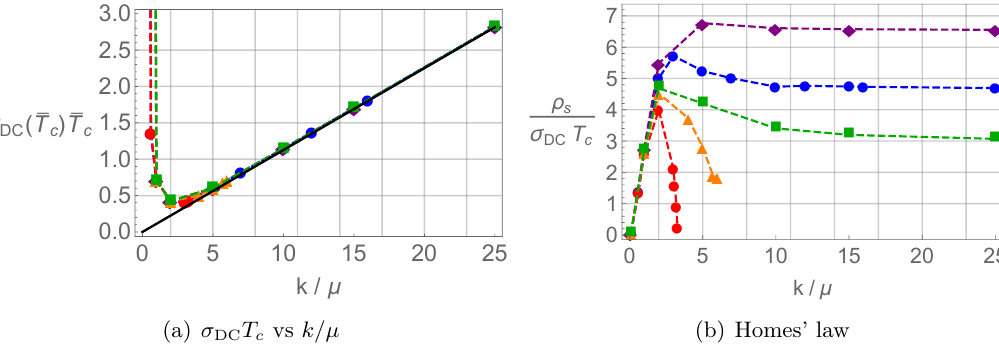
Figure 8 . ρ s /µ, T c /µ, and σ DC for τ = (0 , 1 √ purple). ¯ T c is the shorthand notation for T c /µ . The solid lines in (b) are figure 1 and the dashed lines in (a), (c) are fitting curves.